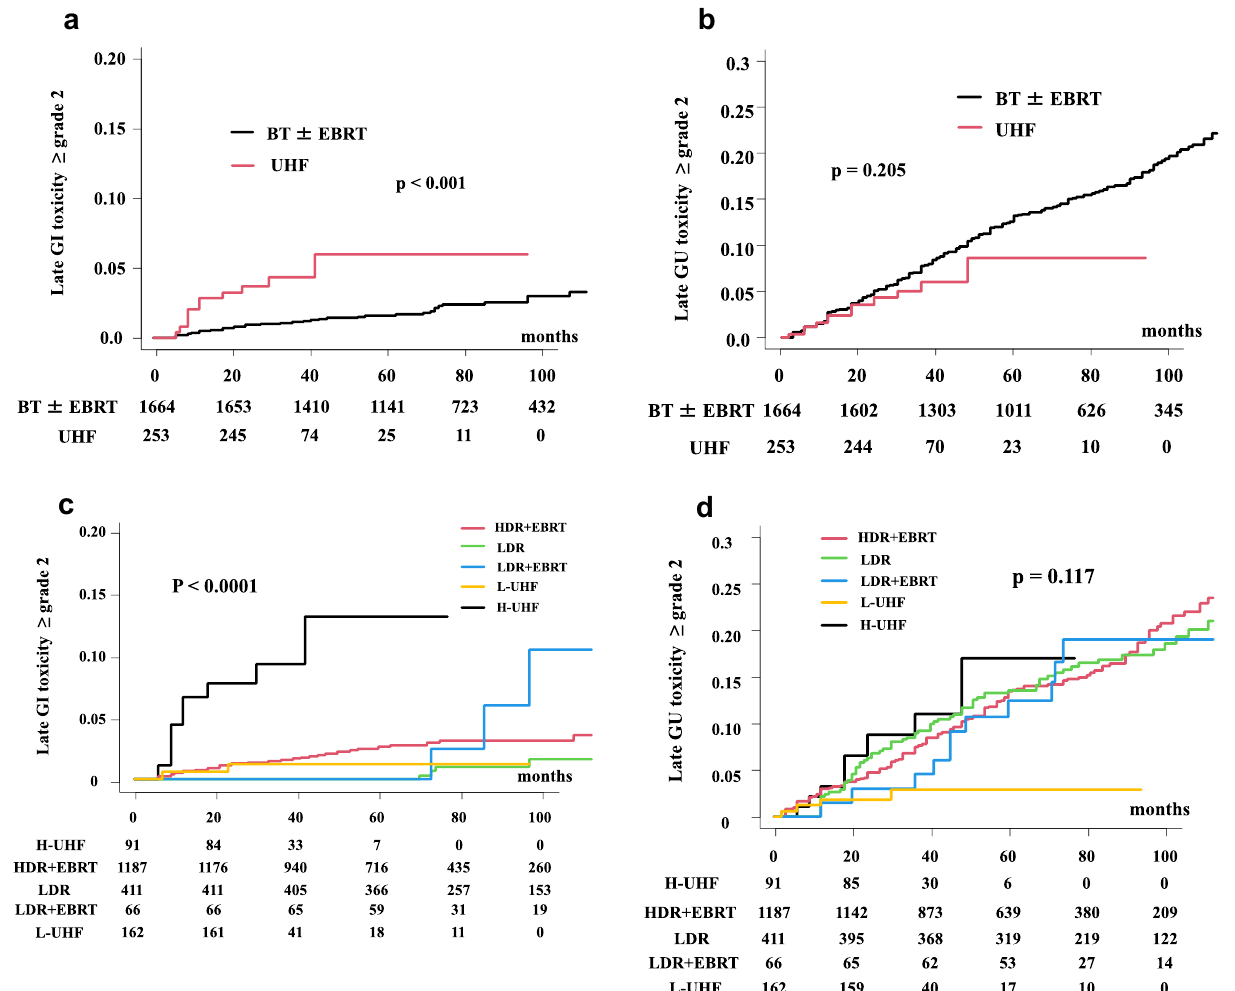
Figure 2. Comparison of accumulated incidence toxicity grade ≥ 2. ( a ) Accumulated incidence of grade ≥ 2 Gastrointestinal (GI) toxicity between BT ± EBRT and UHF. ( b ) Accumulated incidence of grade ≥ 2 Genitourinary (GU) toxicity between BT ± EBRT and UHF. ( c ) Accumulated incidence of grade ≥ 2 GI toxicity among subgroups. (HDR + EBRT vs. LDR + EBRT vs. DR monotherapy vs. L-UHF vs. H-UHF). ( d ) Accumulated incidence of grade ≥ 2 GU toxicity among subgroups. (HDR + EBRT vs. LDR + EBRT vs . LDR monotherapy vs. L-UHF vs.